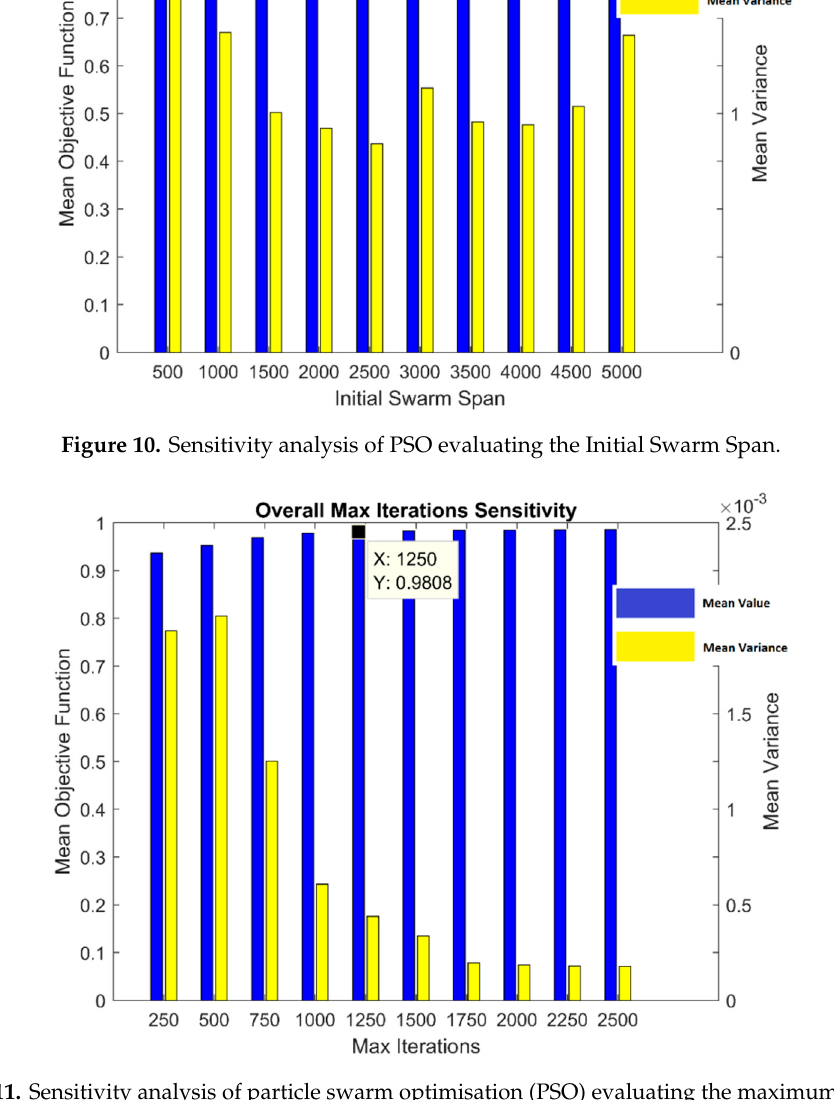
Figure 11. Sensitivity analysis of particle swarm optimisation (PSO) evaluating the maximum number of iterations.